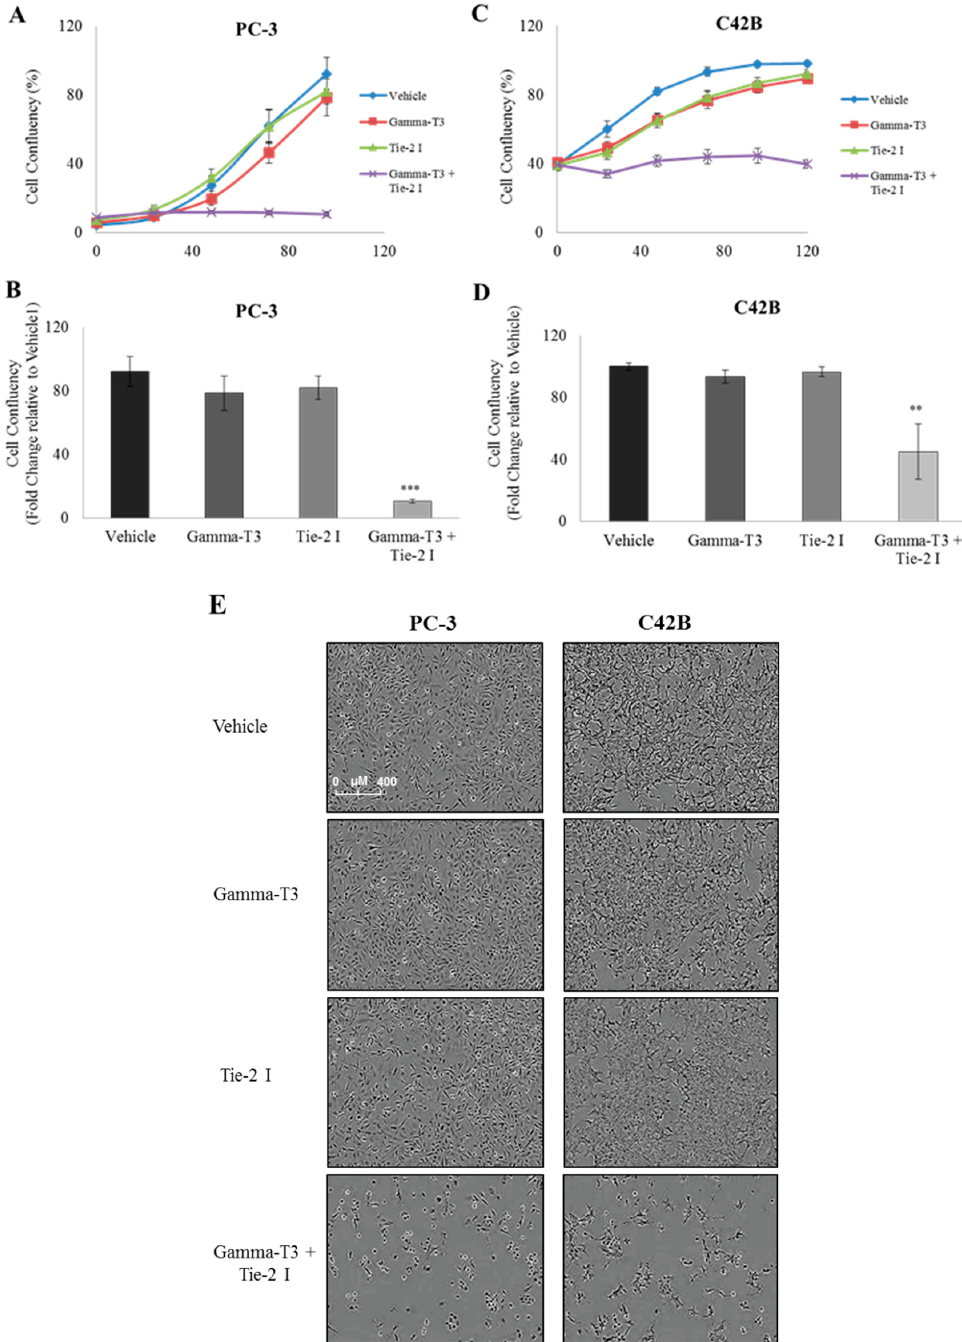
Figure 2. Tie-2 inhibitor promotes the anti-proliferative effect of γ -T3 against prostate cancer cells. Prostate cancer cells were treated with either a single compound ( γ -T3/Tie-2 inhibitor) or a combination of both. Cell confluency (as an indicator to measure the cell growth rate) of PC-3 ( A ) and C42B ( C ) was measured by the live content cell imaging IncuCyte HD system for 96 and 120 h, respectively. Note that the combined effects of Tie-2 inhibitor and γ -T3 when used together significantly suppressed the growth rate in both PC-3 ( B ) and C42B ( D ) at both time points. Cell morphology of PC-3 and C42B ( E ) cells at 96 and 120 h after treatment is shown (10× objective). Each experiment was repeated at least three times, and the results from a representative experiment are presented as the mean ± SD. ( p values: ** < 0.005; *** < 0.0005). Scale bar, 400 µM.